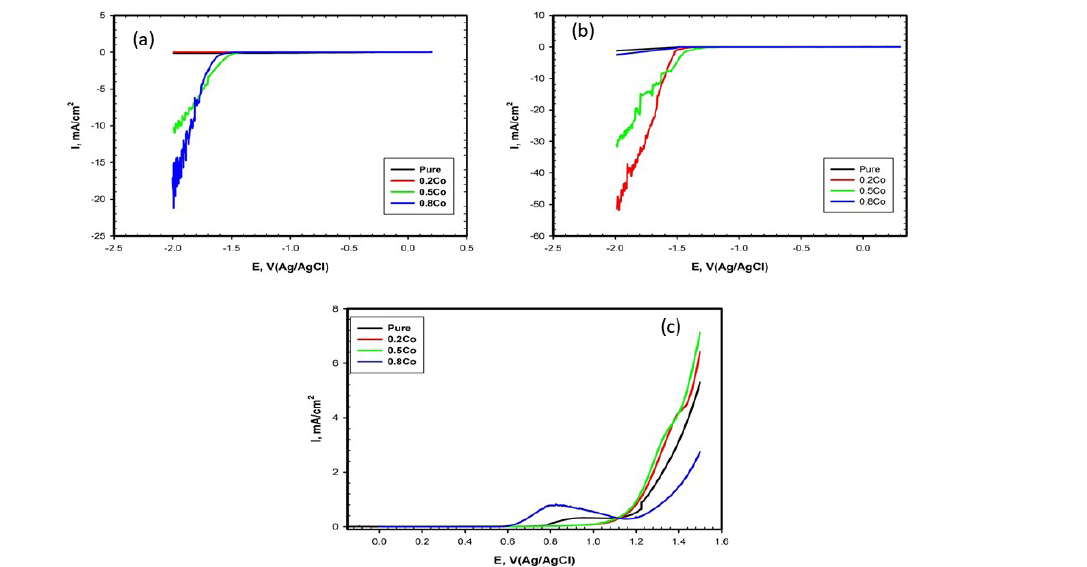
Figure 11. Linear sweep voltammetry at scan rate of 1.0 mV/S in 1.0 M KOH for Zinc Ferrite and Co-Zinc Ferrite prepared by (a) solid state at 800 o C (b, c) microwave at 1000 o